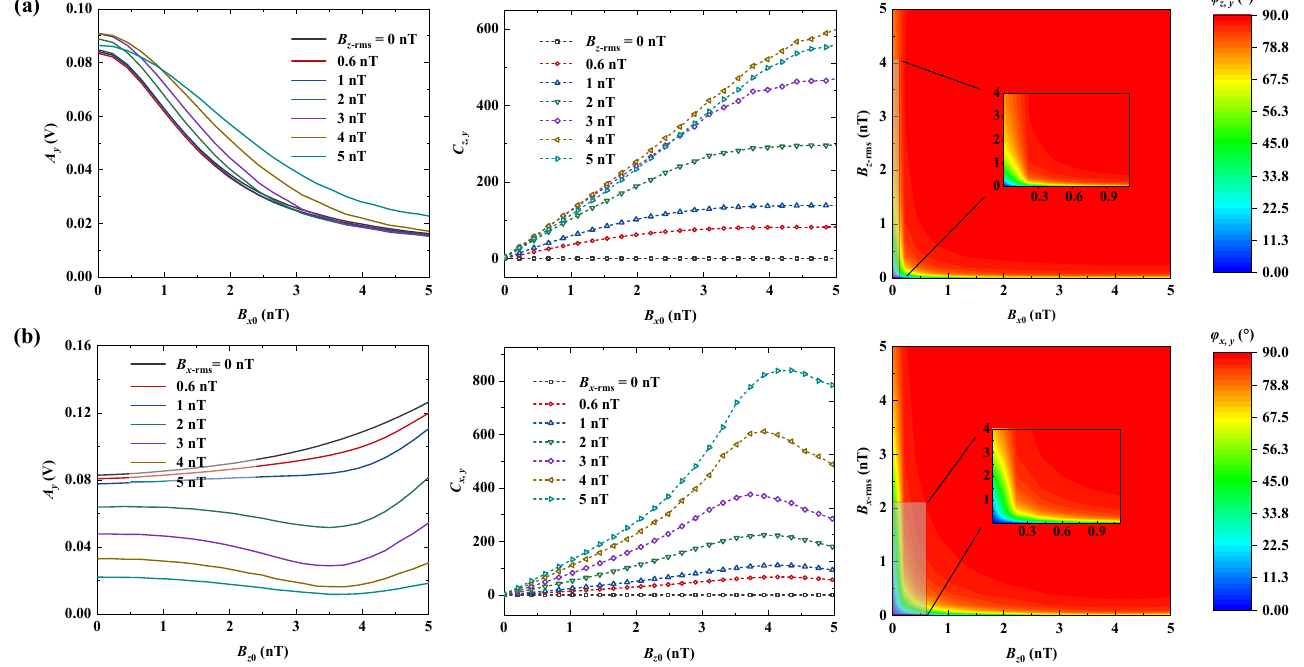
Figure 4. The output amplitude and coupling coefficient dependence on the background field under varied interference field amplitudes. ( a ) A y , C z , y , and φ z, y dependence on B x 0 . ( b ) A y , C x , y , and φ x, y dependence on B z 0 .